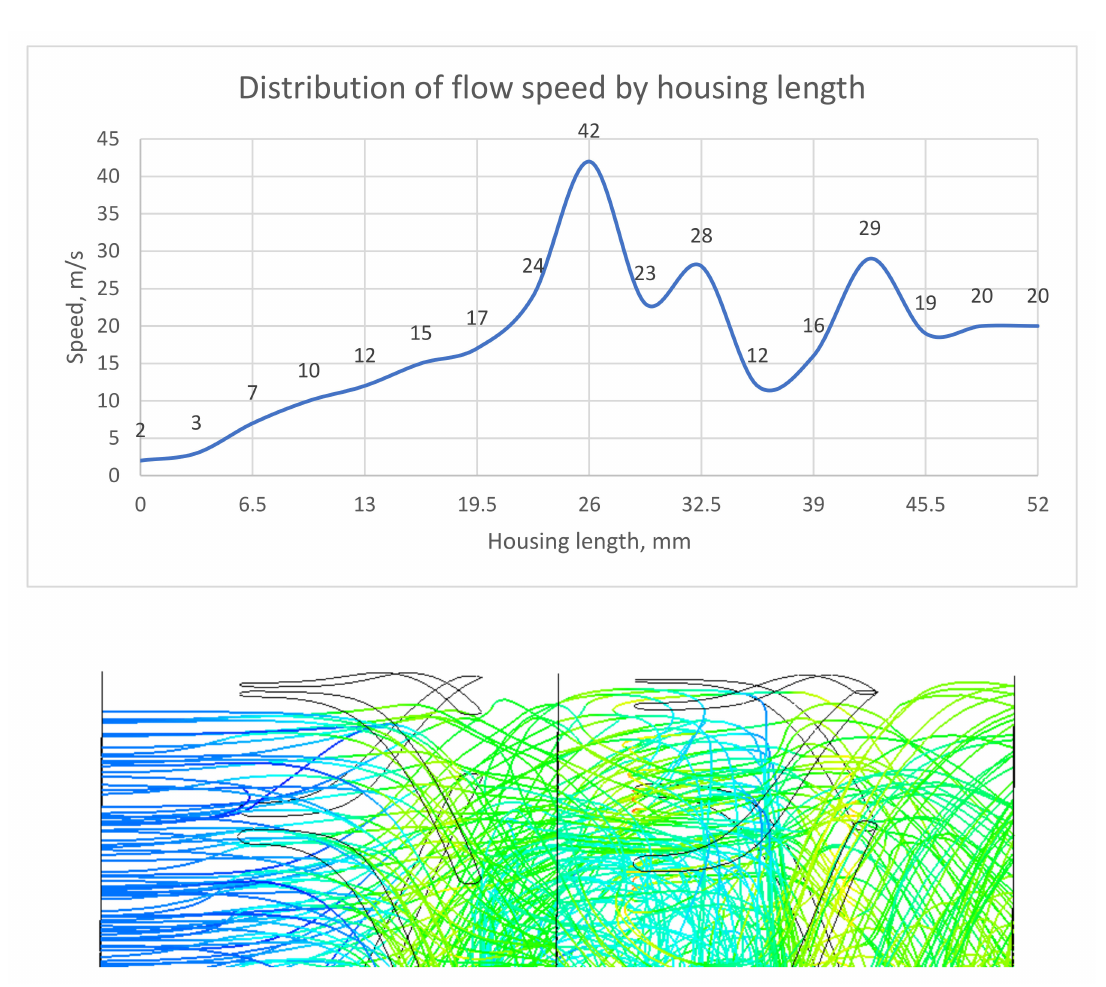
Figure 4. Distribution of the flow velocity along the length of the working pair.